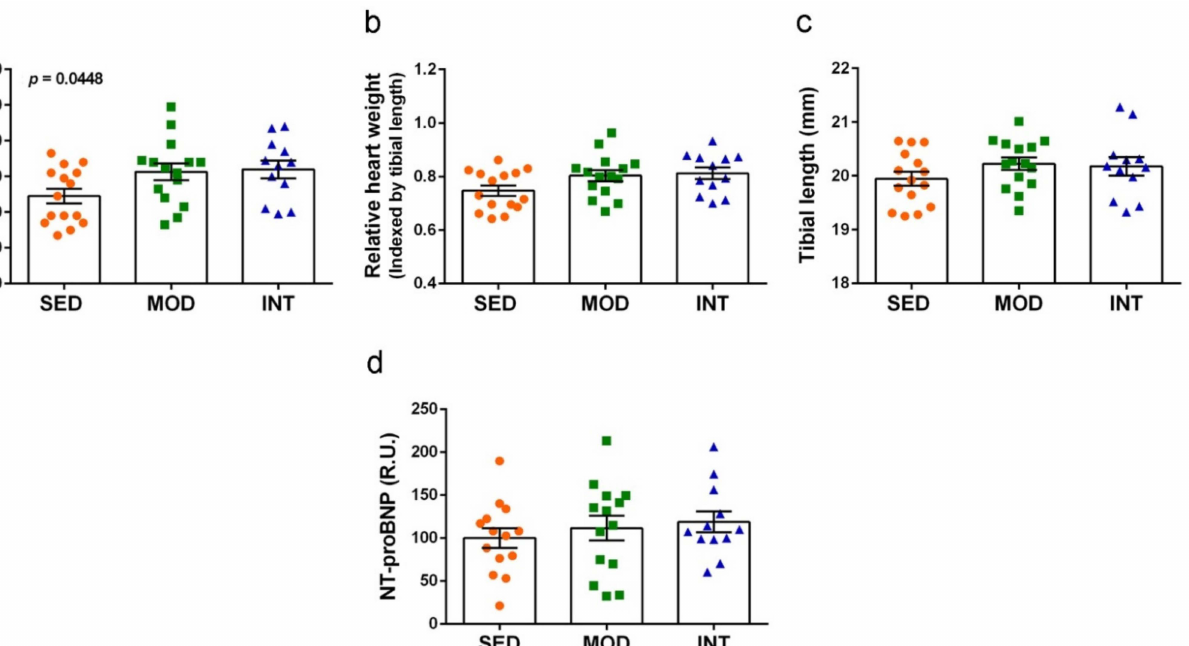
Figure 3. Exercise training induced mild cardiac hypertrophy. ( a ) Heart weight; ( b ) relative heart weight; ( c ) tibial length; ( d ) N -terminal pro B-type natriuretic peptide (NT-proBNP). Experimental groups: SED (orange circles), sedentary; MOD (green squares), moderate training; INT (blue triangles), high-intensity training. Values are mean ± SEM (( a – c ) SED n = 15, MOD n = 15, INT n = 12); ( d ) SED n = 14, MOD n = 14, INT n = 12). Statistics: There was a significant ANOVA effect of exercise treatment without post hoc test significances in ( a ) and a borderline significant effect in ( b